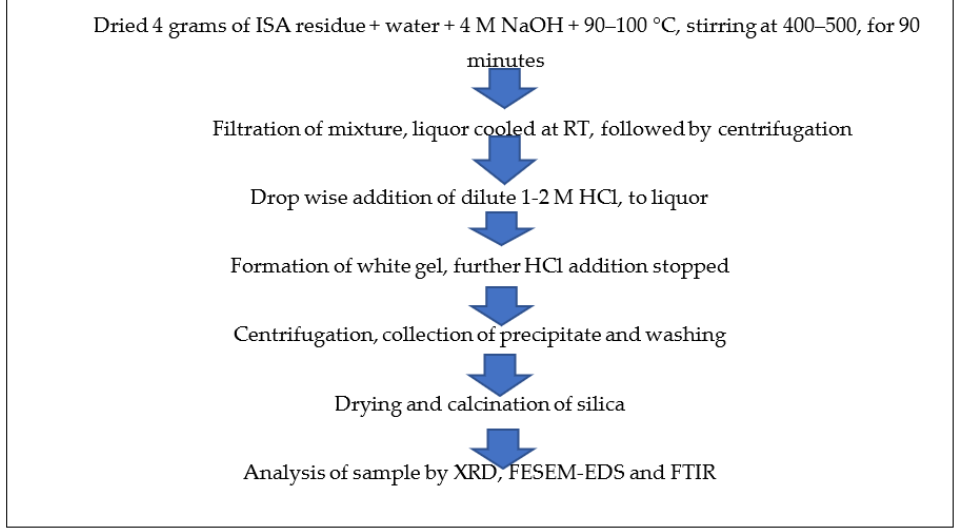
Figure 4. Schematic method for synthesis of silica nanoparticles from non-magnetic fractions of ISA. (5) Synthesis of CaO from ISA